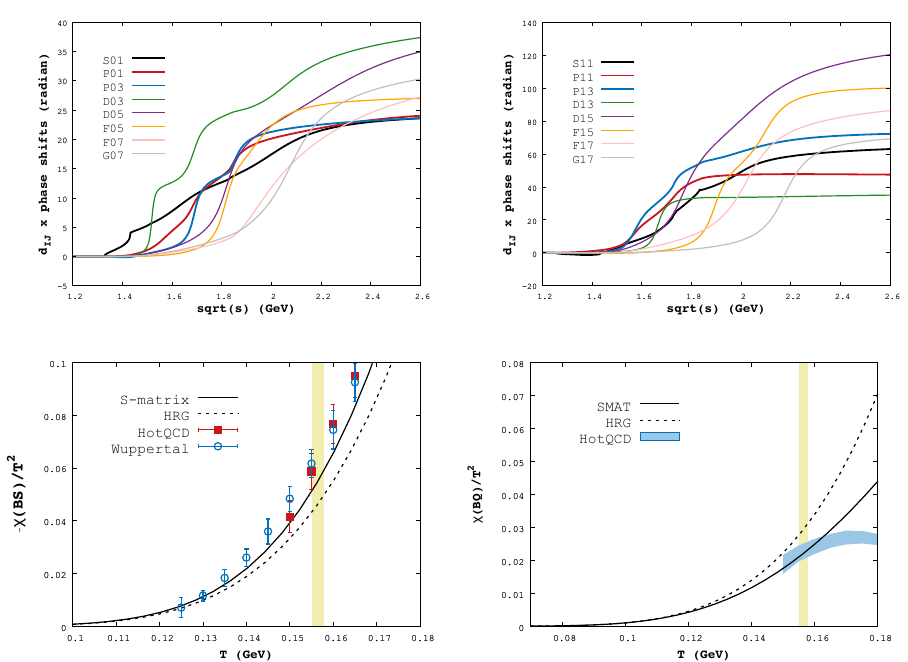
Figure 1. Top: The generalized phase shift function Q l ( s ) extracted from the coupled-channel PWA in Ref. [5]. Shown in the figures are the major channels contributing to the thermodynamics. Bottom: Fluctuation observables computed using the empirical phase shifts, compared with those obtained from the HRG model and